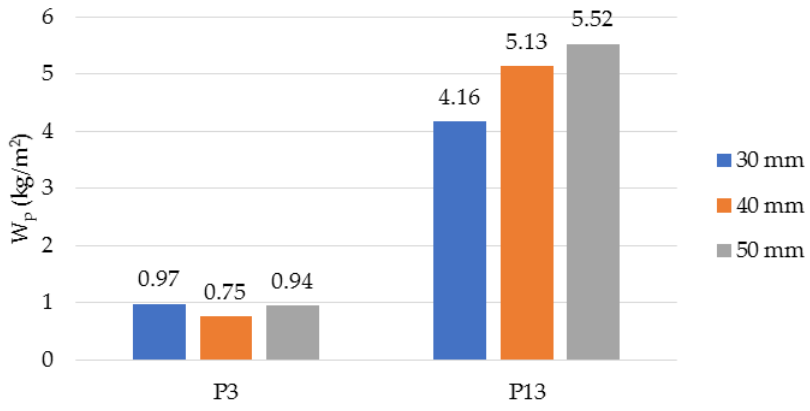
Figure 15. EDX elemental map distribution image of sample P13, magnification ×1000.